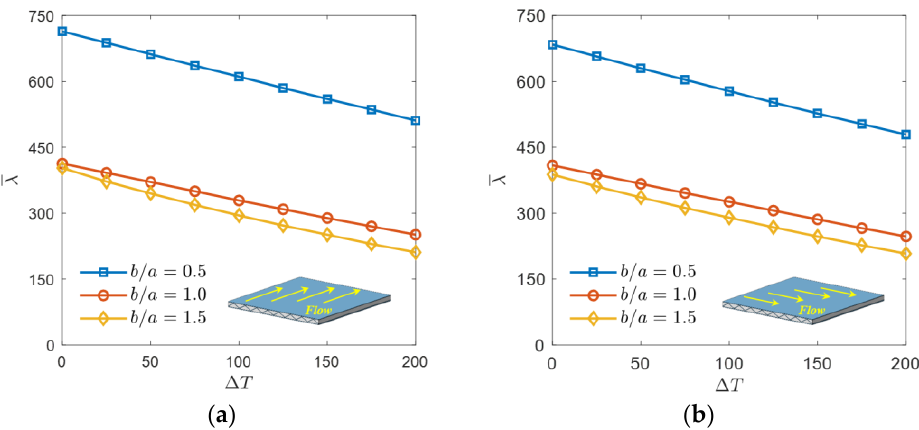
Figure 10. Effects of ( a ) aspect ratio and ( b ) airflow direction on dimensionless critical dynamic pressure against temperature